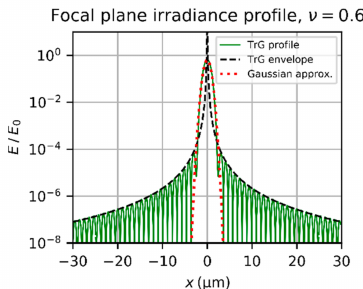
Figure 5. Irradiance profile of the di ff raction pattern of a truncated Gaussian beam (TrG) and its envelope according to Equation (14) and Equation (16), respectively. Calculation parameters: λ = 532 nm, f = 50 mm, F = 2.0, ν = 0.6. Additionally, a Gaussian approximation for the central lobe according to Equation (18) is plotted. The curves are normalized using the peak irradiance E 0 of an Airy di ff raction pattern for same incident power P in